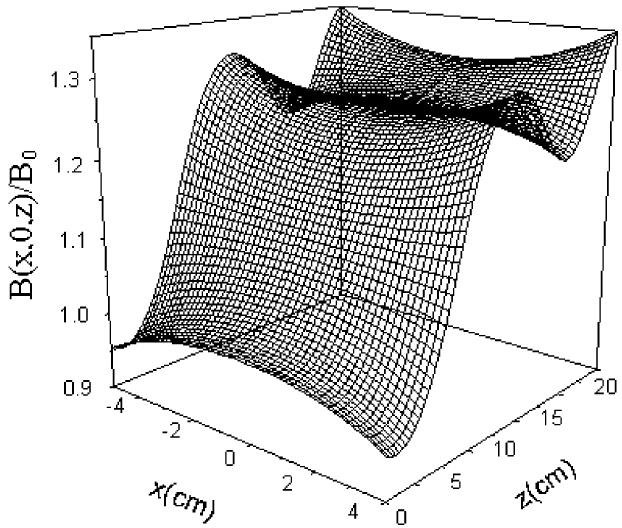
FIG. 2. The profile of the magnetic field in the y (cid:1) 0